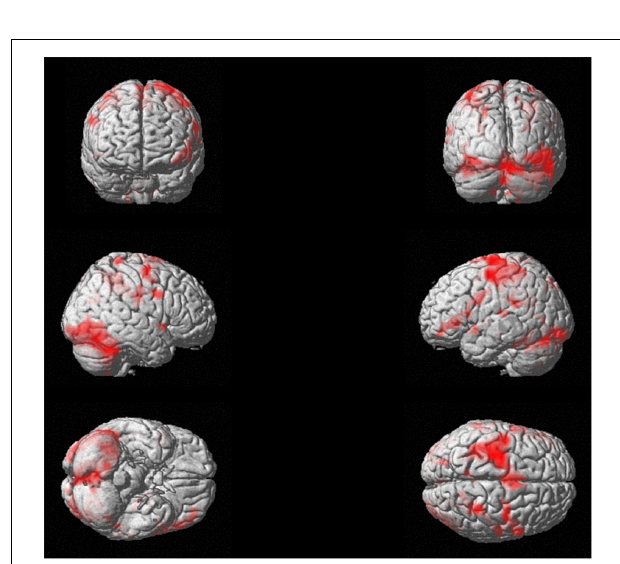
FIGURE 4 | Experiment 2. Task-related brain activation map ( p < 0.05 FWE-corrected; size = 50 voxels) for the handwriting movement task for a representative